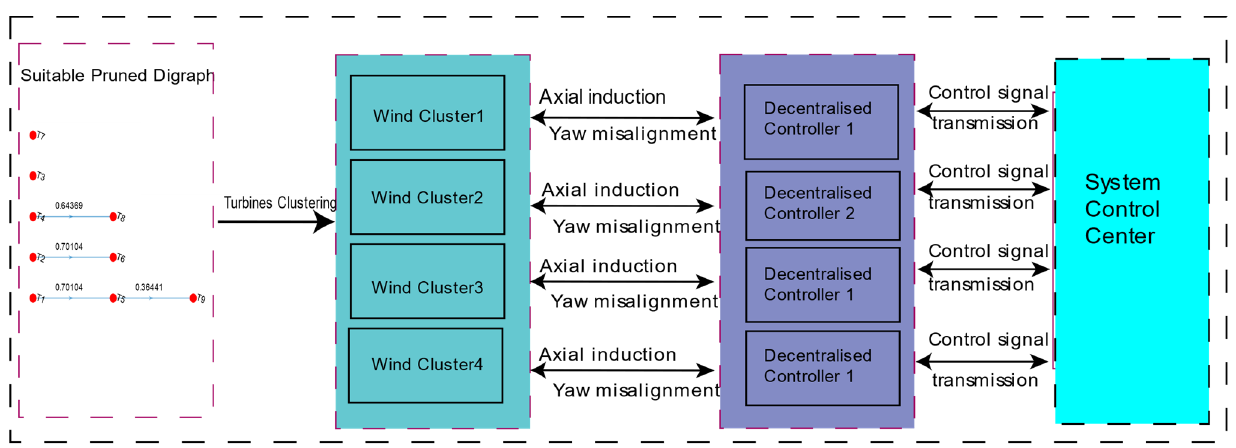
Figure 3. The proposed whole decentralized control scheme on a 3 × 3 turbines offshore wind farm.